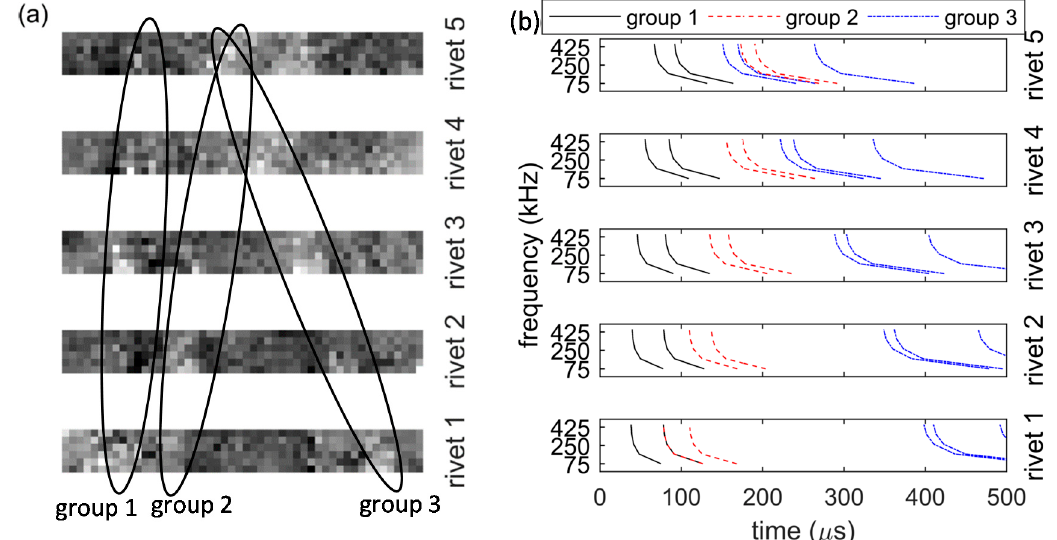
Figure 15. Three arrival groups: ( a ) deep dreams, ( b ) theoretical.